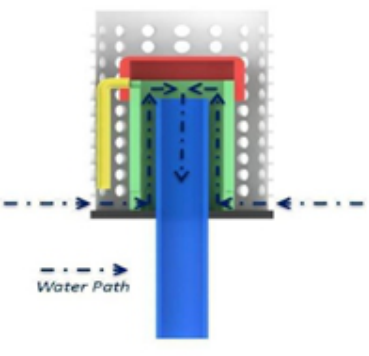
Figure 9. Bell siphon water path (Wikipedia, 2015b)